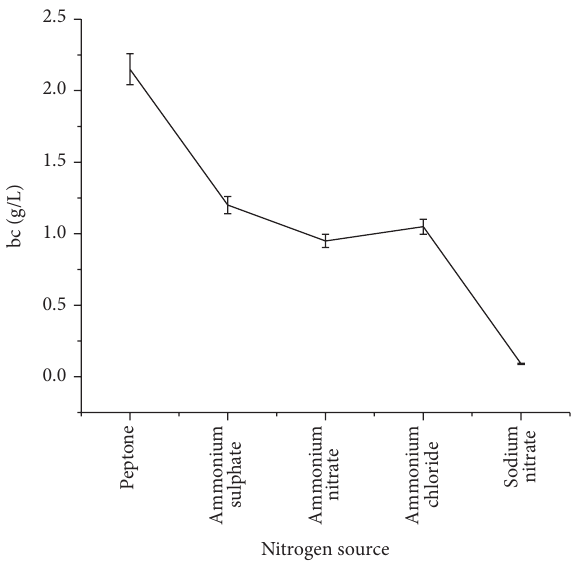
Figure 9: Effect of nitrogen source on cellulose production by Gluconacetobacter